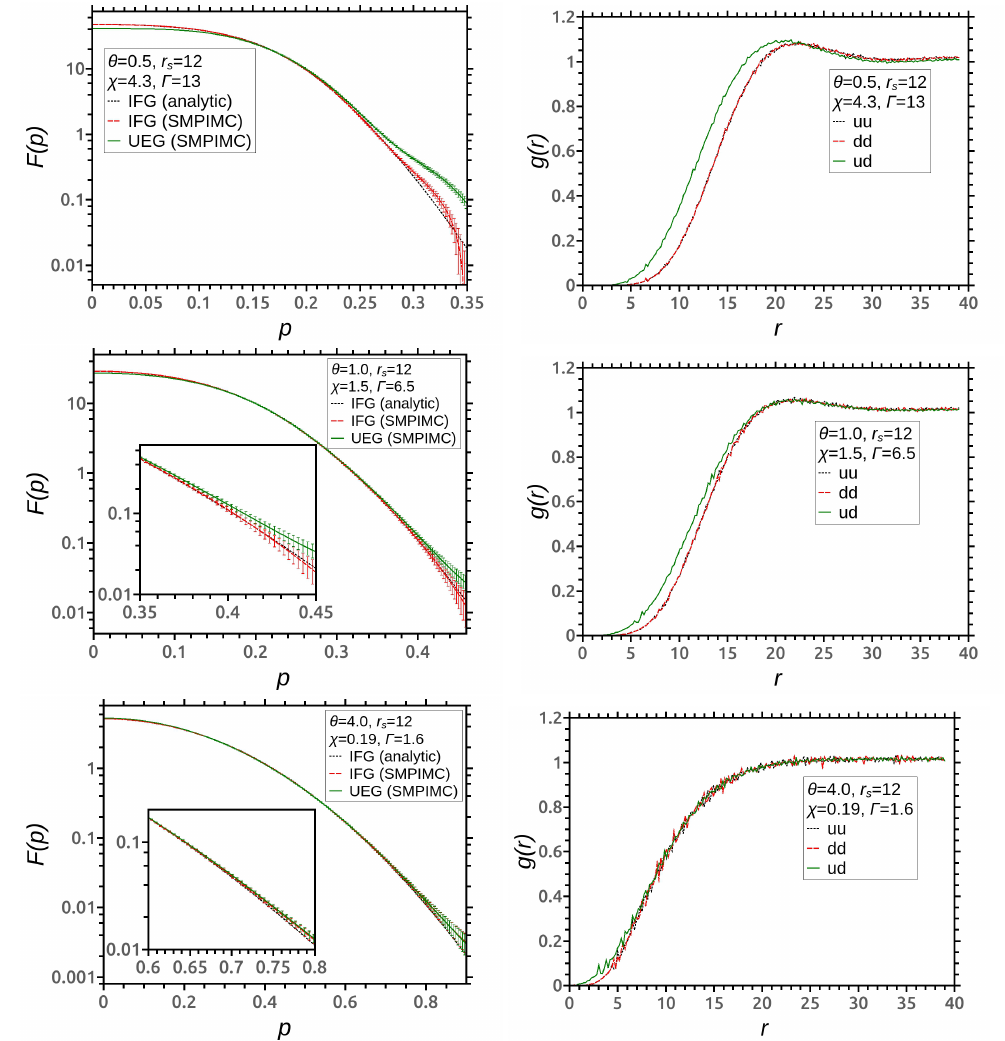
Figure 2. Left plots: single-particle MDFs of the unpolarized UEG at r s = 12 and θ = 0.5,1,4 calculated with the SMPIMC method. The results are compared with the SMPIMC for the IFD at the same conditions and with the analytical Fermi distributions. Right plots: PCFs g uu , g dd and g ud of the